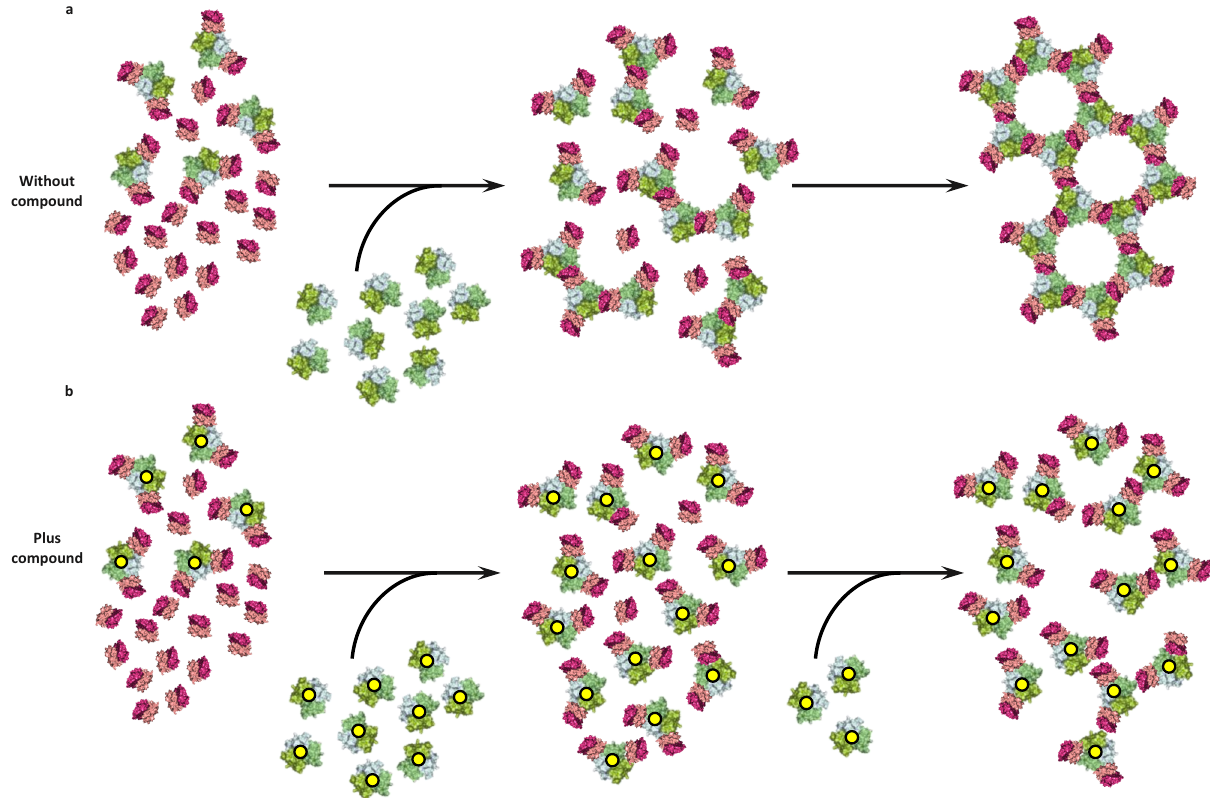
Fig. 6 Model of TNF – TNFR1 signalling network. a Schematic representation of TNFR1 dimers (pink and purple) pre-clustered, with a portion bound to TNF (green) (two copies of TNFR1 dimer bound per TNF trimer). Addition of more TNF (green) results in linking of the TNF-two-receptor-bound units into larger TNF-three-receptor-bound clusters fi nally assembling into a large network. b Same scenario as a in the presence of compound (yellow dots), resulting in incomplete network